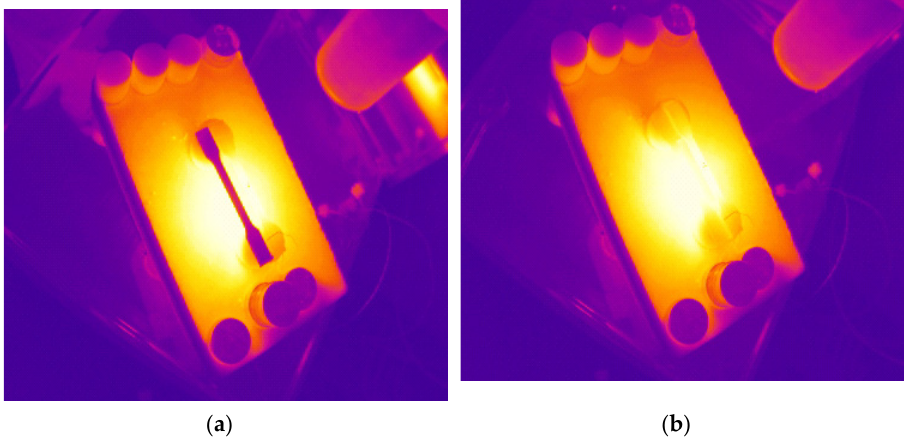
Figure 5. Temperature fields of a tested sample at the beginning ( a ) and at the end ( b ) of the thermal processing procedure.